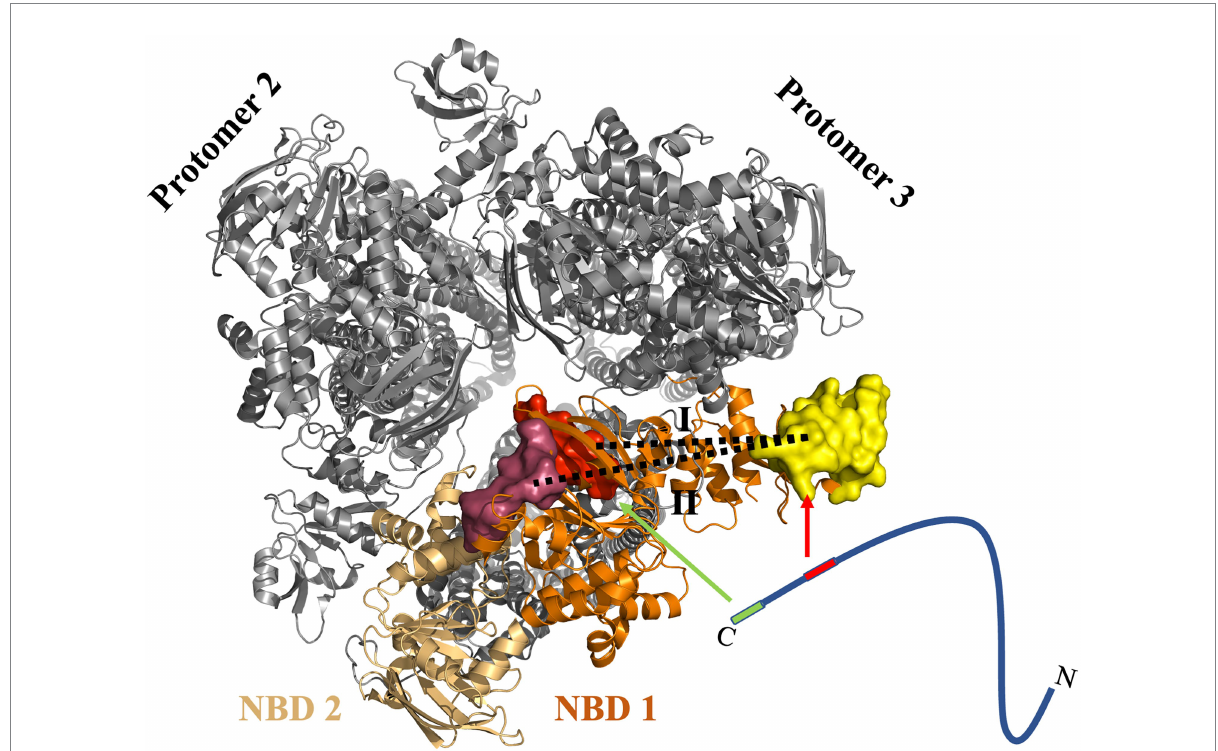
FIGURE 7 Proposed model of the interaction of HlyA with the NBD of HlyB. Cartoon representation of the trimer of dimers (PDB 7SGR) of the HlyB NBDs (Zhao et al., 2022). The view is from the cytosol toward the membrane. The NBDs of the transport-competent HlyB dimer are colored in orange and light orange, respectively, while the two non-transport competent HlyB dimers are shown in gray. The identified pbp’s are shown as surface representation with pbp-in in red and pbp-out in magenta. The yellow surface maps the HlyA-interaction region of the CLD. The substrate, HlyA, is drawn schematically as a line. The two interacting regions of HlyA are highlighted in green (secretion signal) and red (RTX domain). The arrows emphasis the interaction regions within the NBD of HlyB. Please note that the CLD of NBD 2 was not traced in the single particle cryo EM structure (Zhao et al., 2022). For most efficient secretion, HlyA has to interact simultaneously with both regions of the NBD. In the proposed model, a 1:1 stoichiometry of HlyA and HlyB is assumed. However, one cannot exclude a 2:1 stoichiometry as demonstrated for PCAT1 (Kieuvongngam et al.,